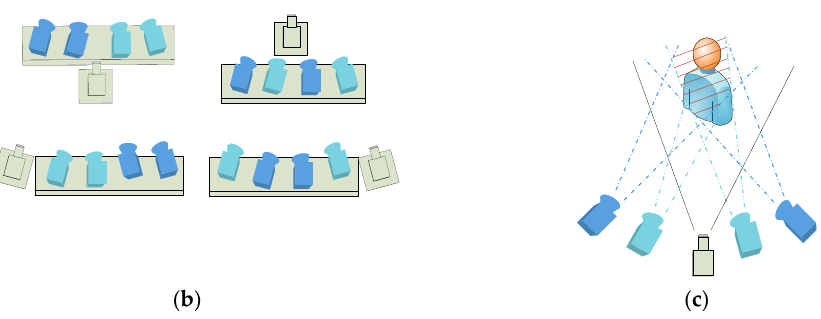
Figure 1. ( a ) System structure; ( b ) sensor layout; and ( c ) common visual field.